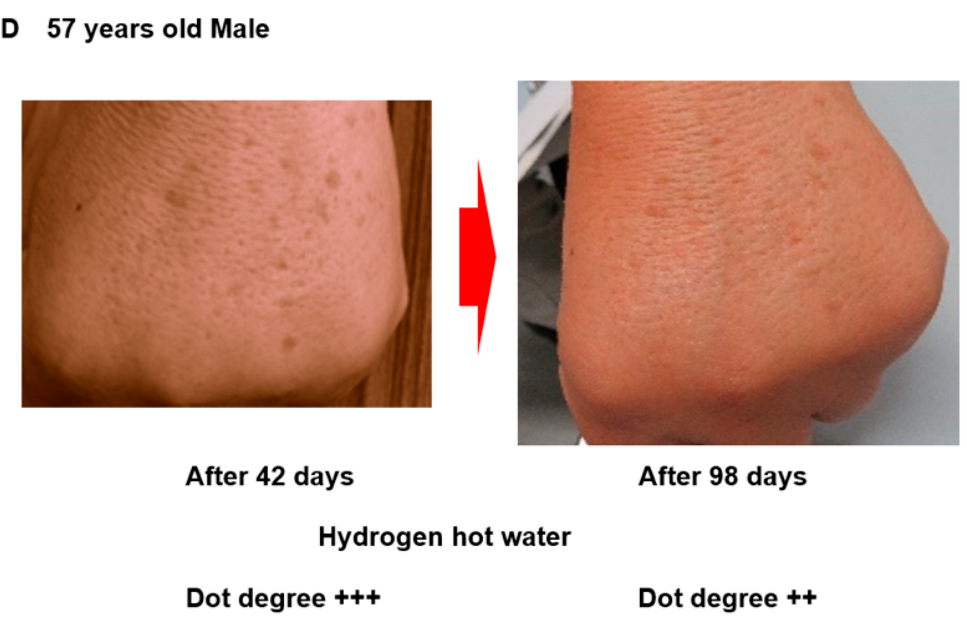
Figure 3. Improvements to blotches in five subjects by bathing and poultice with hydrogen-rich warm water. As in Figure 1A–H, five subjects received the bathing and face poultice with hydrogen- rich warm bath (HW) for 10 min, for 11–98 consecutive days. The face-blotch loci were classified to the degree of area and density of blotches into six hierarchies ( － , +, ++, +++, ++++, +++++). ( A ): Reduction in blotches on right cheek (original and magnified) was observed. ( B ): Reduction in a widespread blotch on the right cheek (indicated by a circle) was observed. ( C ): Reduction in blotches on left cheek (indicated by a box and magnified) was observed. ( D ): Reduction in blotches at back of the left hand was observed.